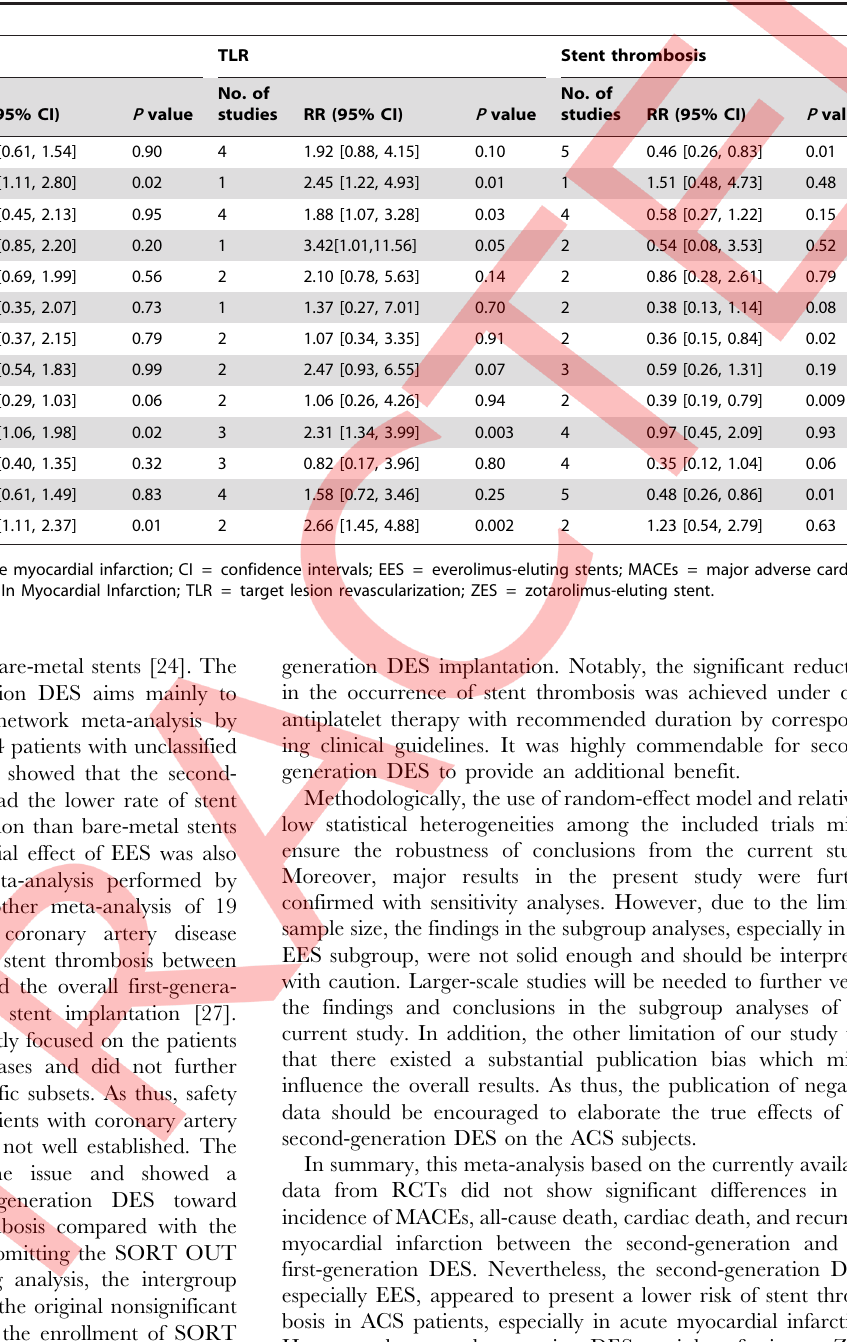
Figure S1 Publication bias analysis using funnel plot method.